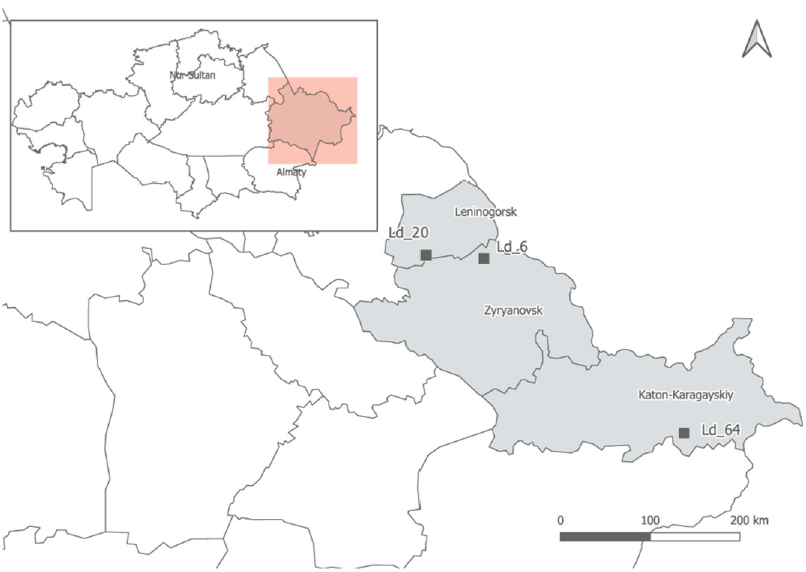
Figure 1. Locations of sample collection of A. ledebourianum in the Kazakhstan Altai territory.